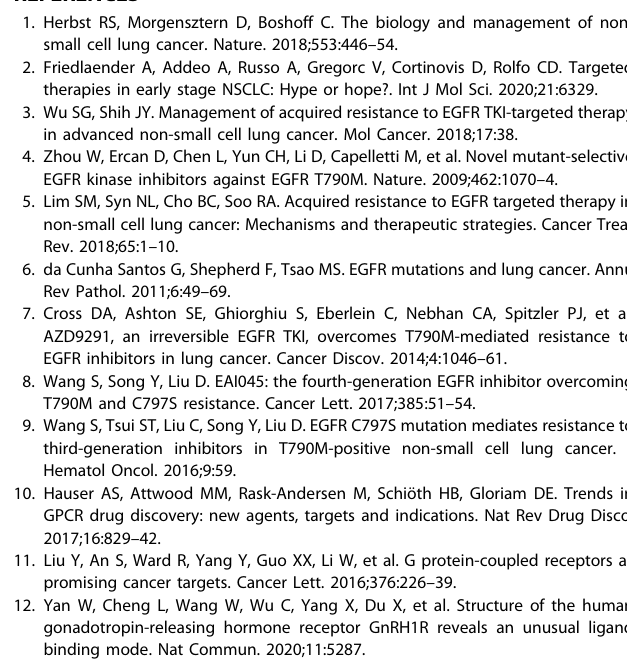
Fig. 8 Combination of aprepitant with EGFR TKIs synergistically inhibited NSCLC cell proliferation. A Cell viability of A549 and NCI-H1944 treated with ge fi tinib (Ge fi , 10 μ M) or osimertinib (Osim, 1 μ M) in the presence or absence of aprepitant (Apre, 20 μ M). B Cell viability of A549 and NCI-H1944 with EGFR knockdown treated with ge fi tinib (Ge fi , 10 μ M) or osimertinib (Osim, 1 μ M) in the presence or absence of aprepitant (Apre, 20 μ M). C , D Cell viability of A549 and NCI-H1944 treated with Apre and Osim/Ge fi at indicated concentrations. FA-CI and isobologram analysis for aprepitant/osimertinib or geftinib combinations was plotted and calculated with Chou – Talalay algorithms. CI < 1 suggest synergism effect; CI = 1 suggest additive effect; CI > 1 suggest antagonism effect. Isobologram analysis represents the synergism of a combination of aprepitant with TKIs. Data were shown as mean ± SD from three independent experiments. * P < 0.05, ** P < 0.01, *** P < 0.001. E Working model. NK1R regulates interaction with EGFR, inducing the phosphorylation of ERK/AKT in NSCLC cells and promoting tumors